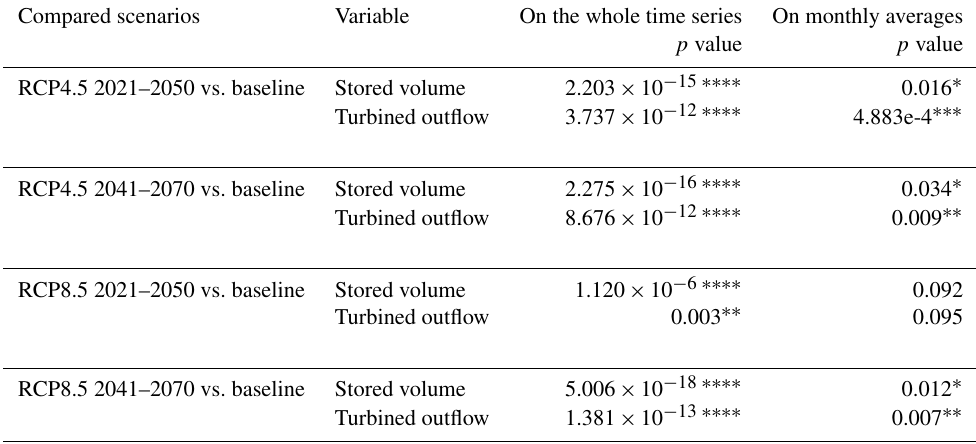
Table 5. Summary of the Wilcoxon rank sum test application to stored volume and turbined outflow for the four scenarios compared to the baseline (1999–2004 and 2009–2016); p values are reported for the test considering the whole time series of future and baseline values and on paired monthly